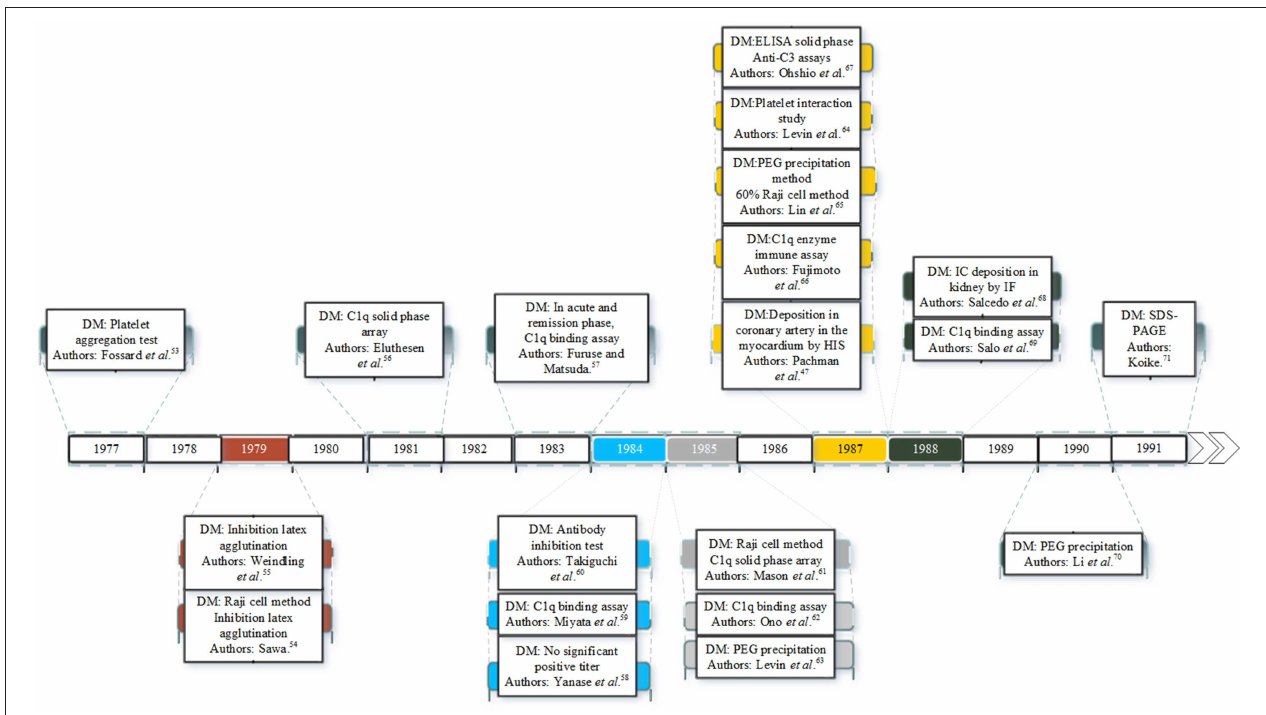
FIGURE 1 | Studies of IC detection in KD patients. DM is the detection method.